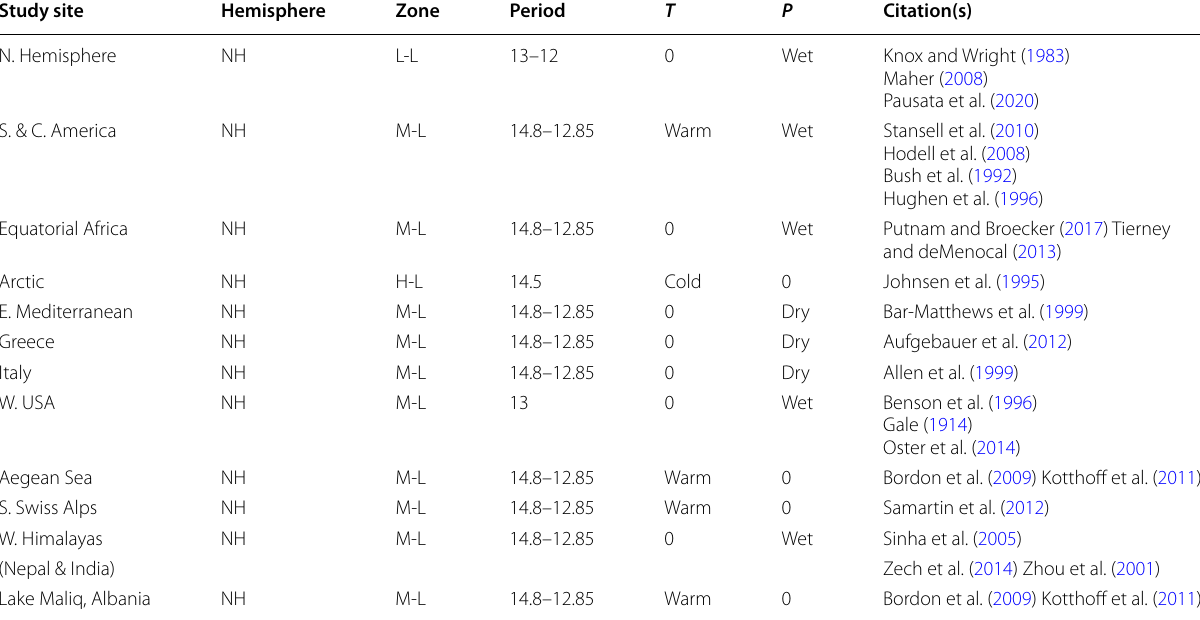
Table 5 Temperature and precipitation conditions during the Bølling–Allerød